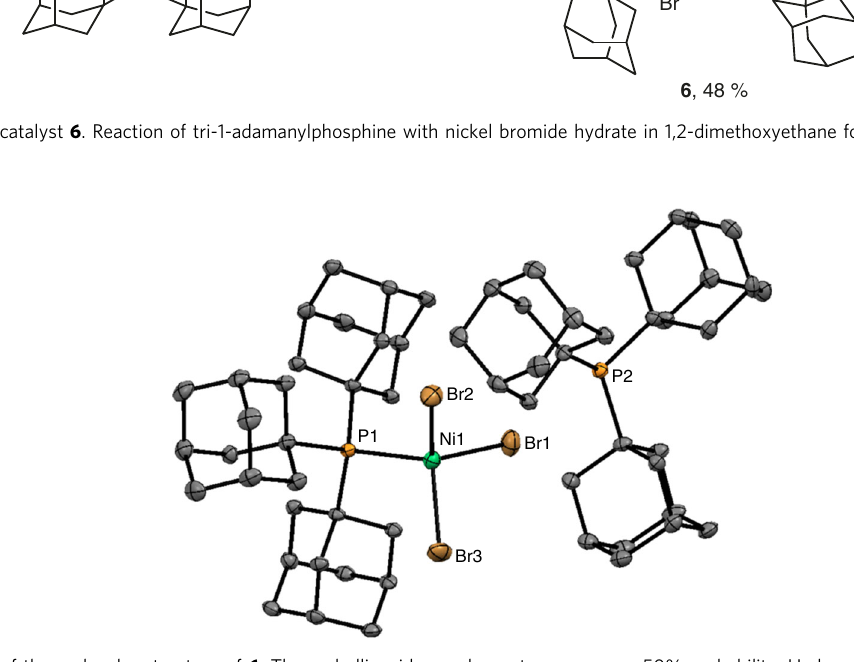
Fig. 3 ORTEP view of the molecular structure of 6 . Thermal ellipsoids are drawn to encompass 50% probability. Hydrogens and co-crystallized chlorobenzene are omitted for clarity. Selected bond distances (Å) and angles (deg.): P(1)-Ni(1) 2.3821(8); Ni(1)-Br(1) 2.4002(6); P(1)-Ni(1)-Br(1) 111.52 (3); Br(3)-Ni(1)-Br(2)